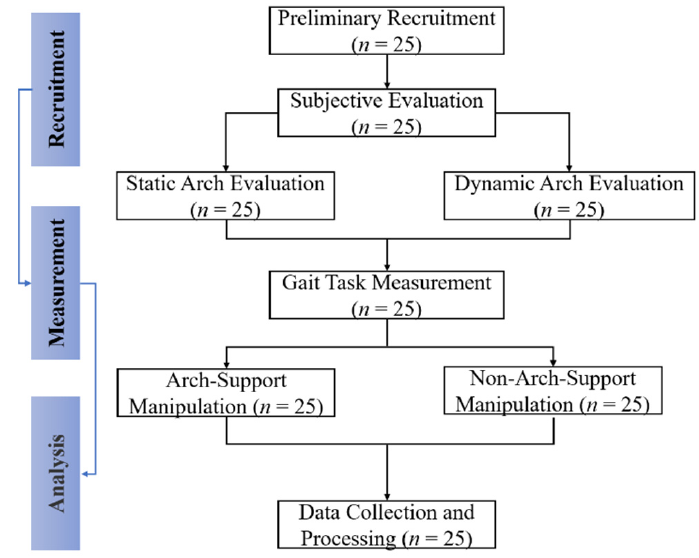
Figure 1. The flow chart of arch support manipulation intervention protocol.